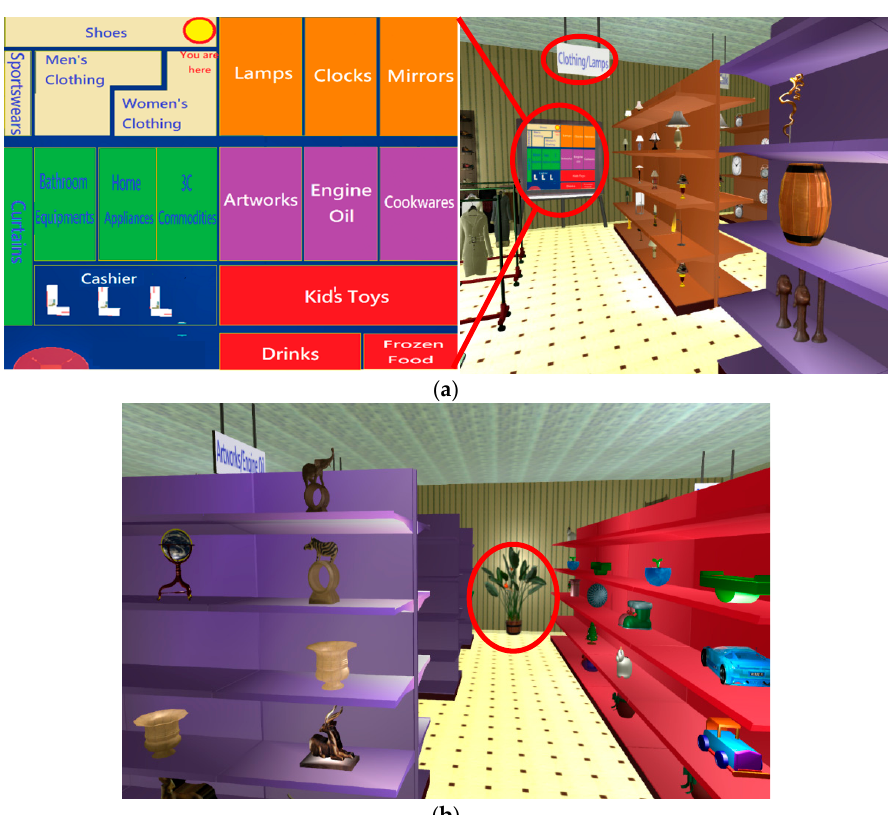
Figure 5. Signage system of the 3D virtual retail store: ( a ) signpost maps are prominently placed in the store; the color of each section corresponds to the section on the map; signs for each section are hung above each shelf; ( b ) landmarks are placed at forks and corners of each aisle (e.g., potted plant).